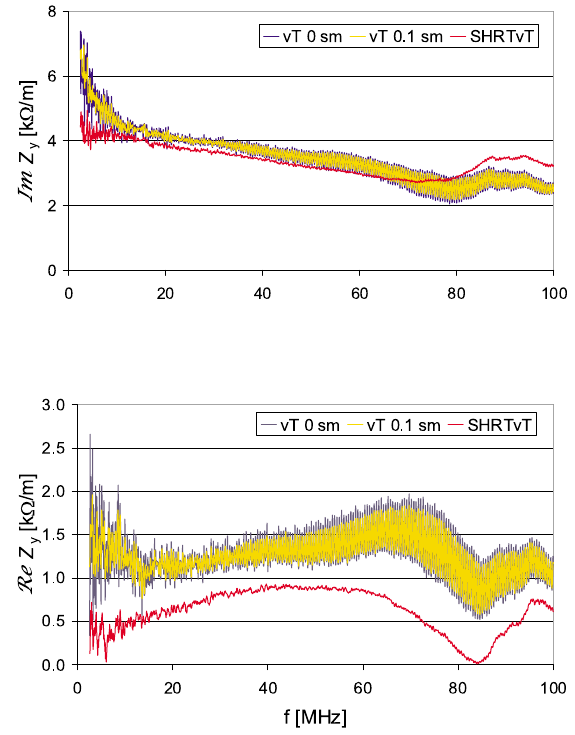
FIG. 20. (Color) Vertical Impedance of the kicker system.